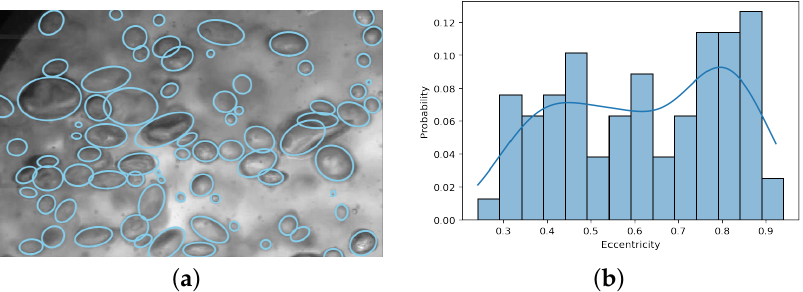
Figure 31. StarDist method application: bubble approximations by ellipses ( a ) and eccentricities of bubbles ( b